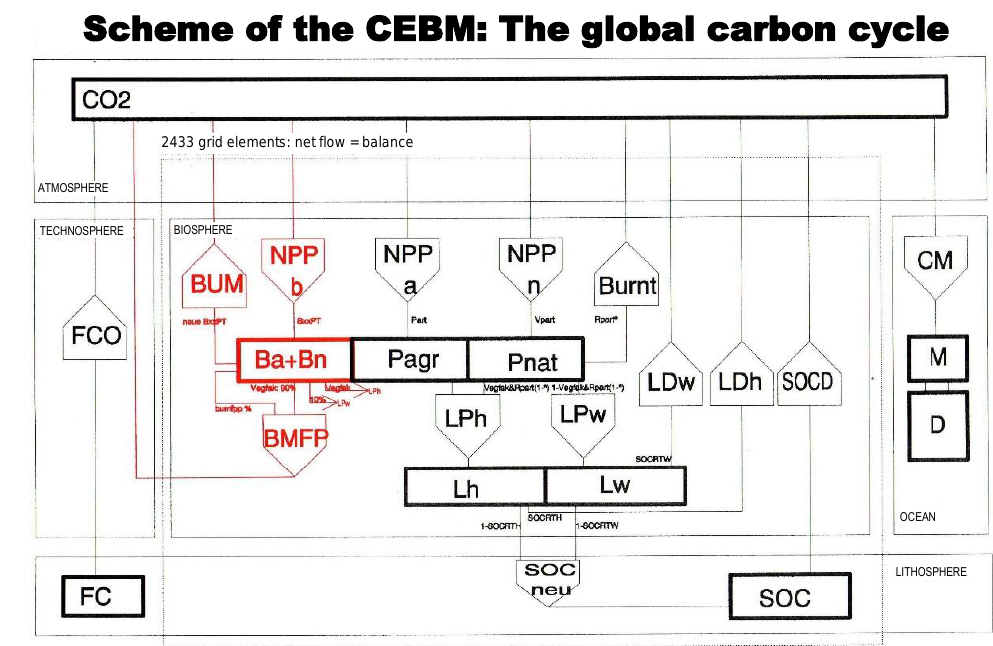
Figure 1. The structure of the global carbon reservoirs (rectangles) and flows (arrows) in the CEBM [32,33], computed on 2433 grid elements. Legend (for more details see in Appendices A and B and [24]): The red program module describes growth (NPPb) and production (BMFP) of biomass fuels; BUM = biomass standing on former areas that are later used for BM fuel growth: this standing BM may or may not be combusted as well. Other compartments are: NPP = net primary productiv- ity (on a = agricultural and n = natural areas), Burnt = deforestation, L = litter (leaves and twigs), LP = litter production (h = herbaceous and w = woody), LD = litter depletion, SOC = soil organic carbon (neu = formation and D = depletion) M and D = mixed and deep layers of global ocean, CM = net uptake by the ocean, FC = fossil carbon, FCO = fossil